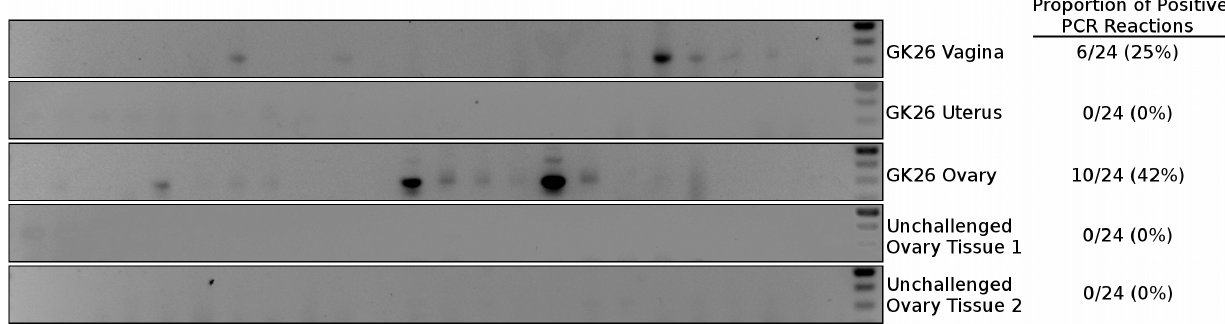
Figure 8. Nested PCR of macaque tissues. Distribution of LICh reporter DNA-positive tissues in the female reproductive tract after inoculation with JRFL pseudotyped LICh vector. Results are based on the number of mCherry positive reactions, with at least 24 reactions per experiment. Gel shown is representative of three independent DNA extractions and amplifications.